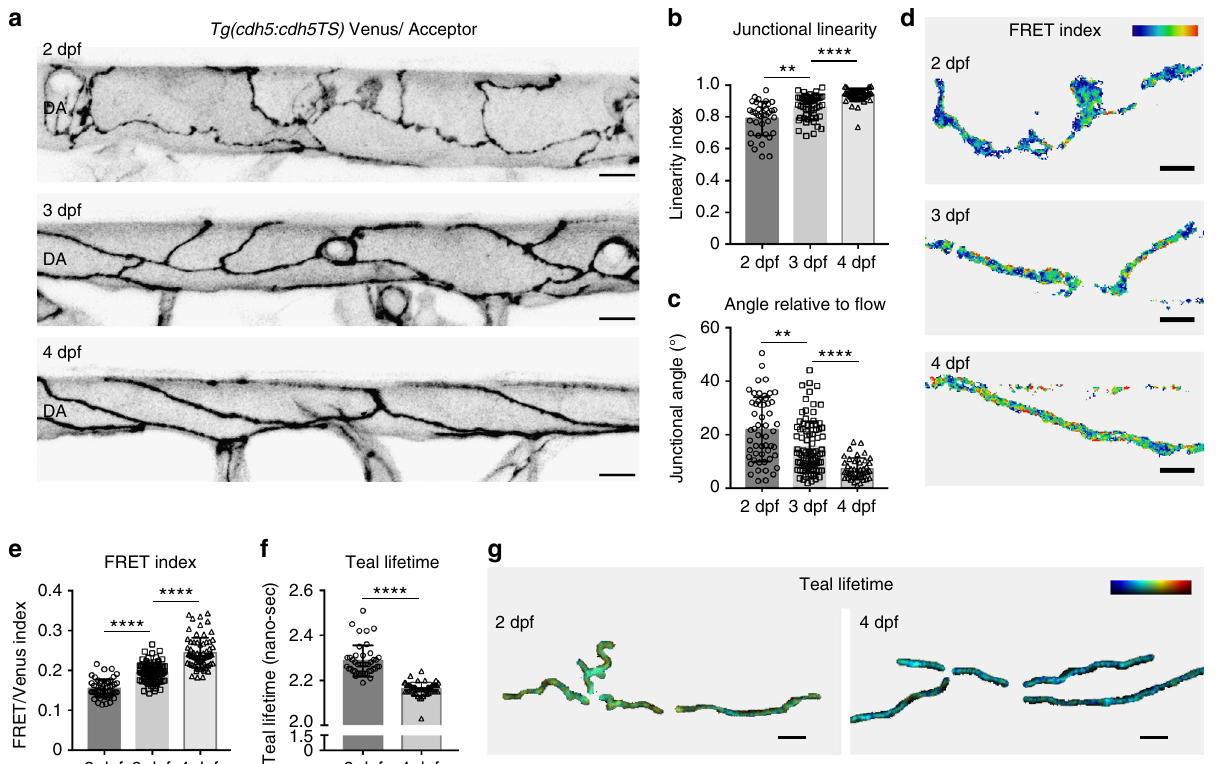
Fig. 3 Cellular morphology and VE-cadherin tensile changes occur during artery maturation. a Junctional morphology of ECs in the dorsal aorta (DA) (Venus, grey) at 2 dpf (top), 3 dpf (middle) and 4 dpf (bottom). Scale bar = 10 μ m. b Junctional linearity index over time at 2 dpf ( n = 37 junctions from n = 4 embryos), 3 dpf ( n = 37 junctions from n = 5 embryos) and 4 dpf ( n = 51 junctions from n = 4). Error bars represent mean ± s.d.; 2 – 3 dpf ** p = 0.0010; 3 – 4 dpf **** p < 0.0001, from unpaired two-sided Mann – Whitney test. c Junctional angle relative to the direction of blood fl ow over time at 2 dpf ( n = 53 junctions from n = 4 embryos), 3 dpf ( n = 89 junctions from n = 5 embryos) and 4 dpf ( n = 42 junctions from n = 4). Error bars represent mean ± s.d.; 2 – 3 dpf ** p = 0.0010; 3dpf – 4dpf **** p < 0.0001 from unpaired two-sided Mann – Whitney test. d Heatmap image of ratio-metric FRET values in junctions at 2 dpf (top), 3 dpf (middle) and 4 dpf (bottom). Colors range from blue ( = low FRET index/high tension) to red ( = high FRET index/low tension). Scale bar = 5 μ m. e Quanti fi cation of ratio-metric FRET values in junctions at 2 dpf ( n = 54 junctional ROIs from n = 4 embryos), 3 dpf ( n = 79 junctional ROIs from n = 5 embryos) and 4 dpf ( n = 71 junctional ROIs from n = 4 embryos). Error bars represent mean ± s.d.; 2 – 3 dpf **** p < 0.0001, from unpaired two-sided t test; 3 – 4 dpf **** p < 0.0001 from unpaired two-sided Mann – Whitney test. f Quanti fi cation of Teal lifetime values (nano-sec) comparing n = 43 junctional ROIs segmented from 2 dpf embryos ( n = 8) and n = 54 junctional ROIs from 4 dpf embryos ( n = 10). Error bars represent mean ± s.d.; **** p < 0.0001 from unpaired two-sided Mann – Whitney test. g Heatmap image of Teal lifetime values in junctions of 2 dpf (left) versus 4 dpf (right) embryos. Colors range from blue ( = low lifetime/low tension) to red ( = high lifetime/high tension). Scale bar = 5 μ